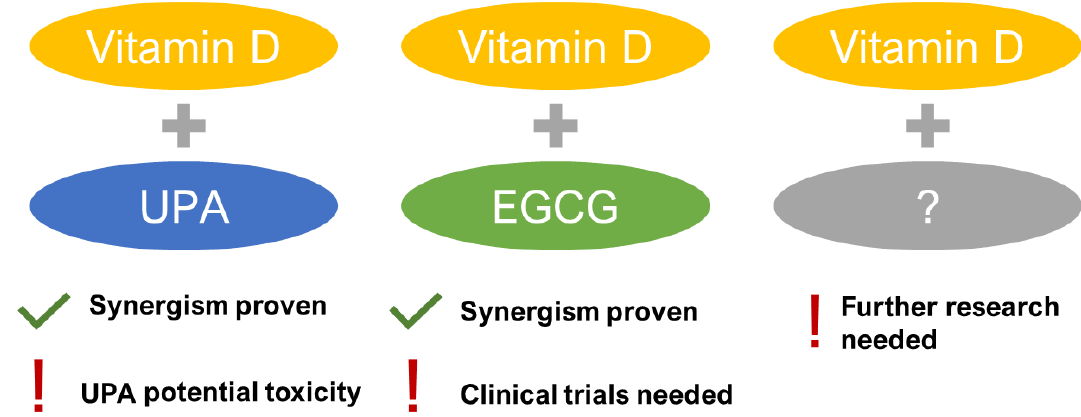
Figure 2. Synergistic combinations of Vitamin D in uterine fibroid (UF) therapy. EGCG: epigallocatechin gallate, UPA: ulipristal acetate.